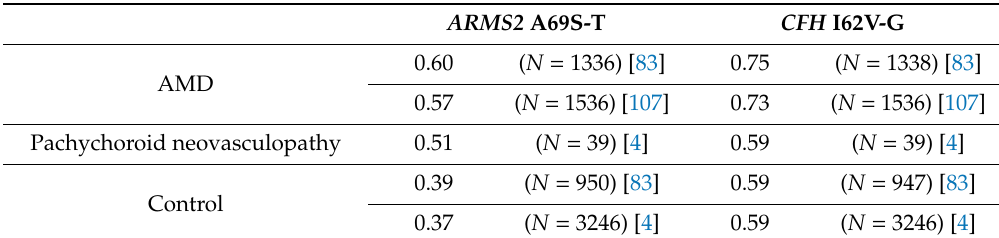
Table 6. Risk allele frequencies for age-related macular degeneration in